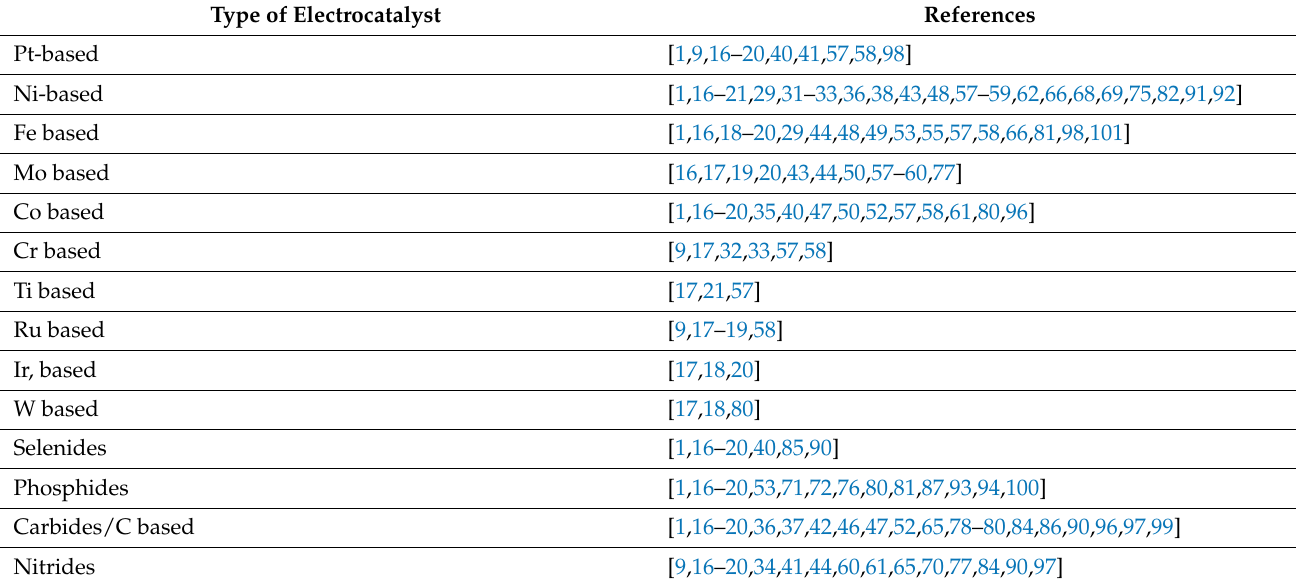
Table 2. Transition-metal-based electrocatalysts for different water electrolysis cells. Type of